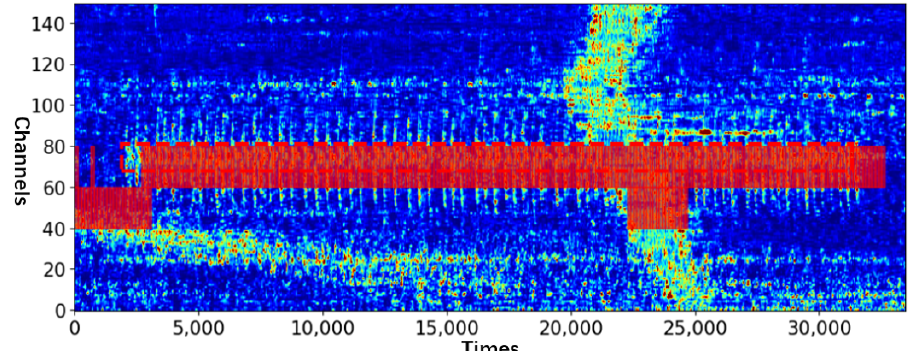
Figure 9. After the accumulation of the model test result window, the red boxes are the detected intrusion windows.